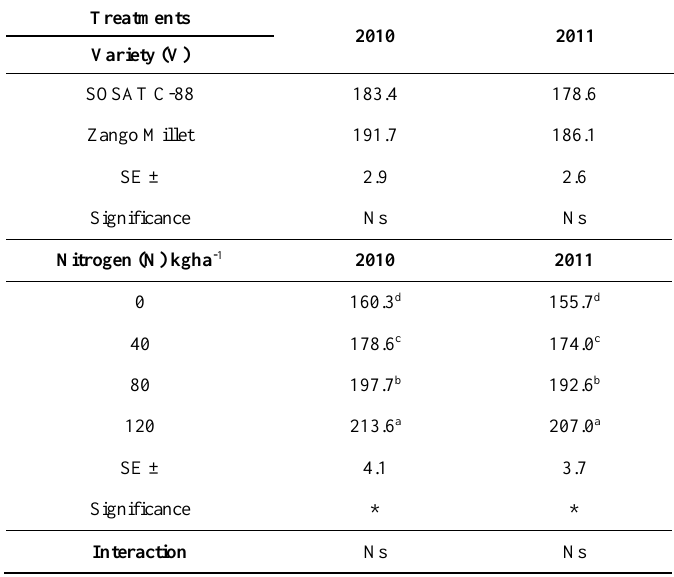
Table 3. Effect of varieties, nitrogen levels on Plant height at maturity in 2010 and 2011 cropping seasons at Usmanu Danfodiyo University Teaching and Research Dry Land Farm,